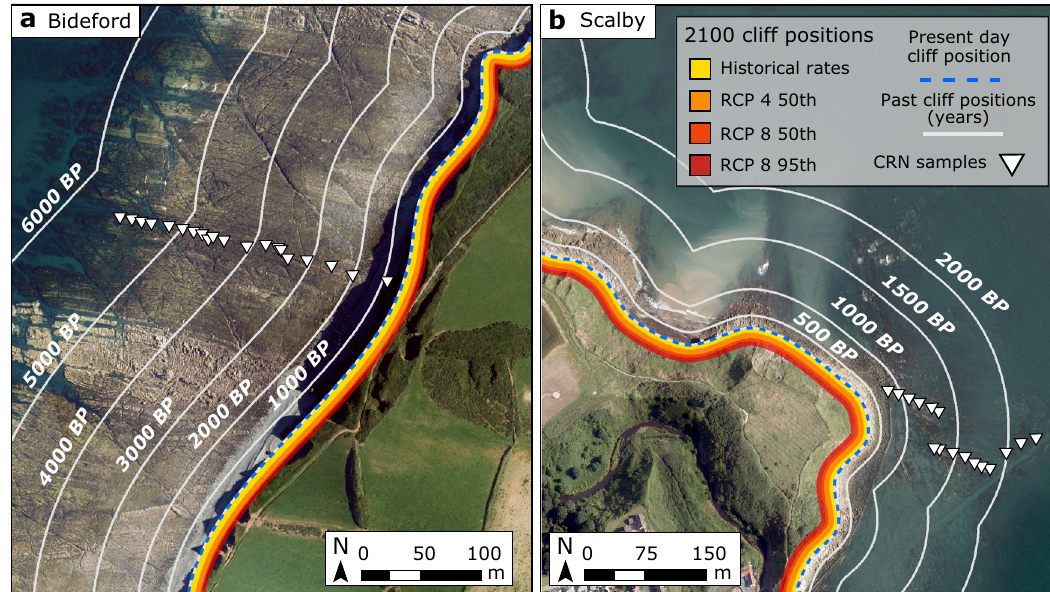
Fig. 5 | Year 2100 and past modelled cliff positions. Bideford site ( a ) and Scalby site ( b ). Future forecasts of cliff positions are shown for the year 2100 based on projections of observed historical retreat rates and Representative Concentration